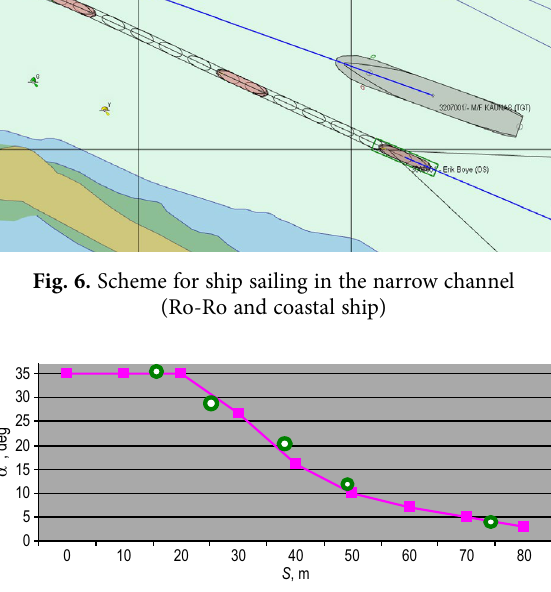
Fig. 7. Hydrodynamic interactions between real ships (Ro-Ro vessel ( L = 200 m) and tested coastal ship ( L = 54 m; S p = 4.0 m; H = 12 m; T = 3.5 m) (green marks) and theoretical calculation results received using the methodology discussed in the